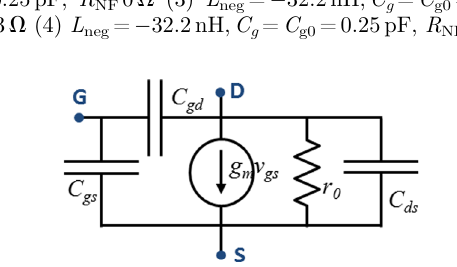
Fig. 4. Equivalent circuit modeling a patch array: short- circuited transmission line connected to a capacitance, thus forming a LC series resonant circuit. ( L d : short-circuit inductor, C g : patch +lumped capacitor, Z NF : NF impedance).